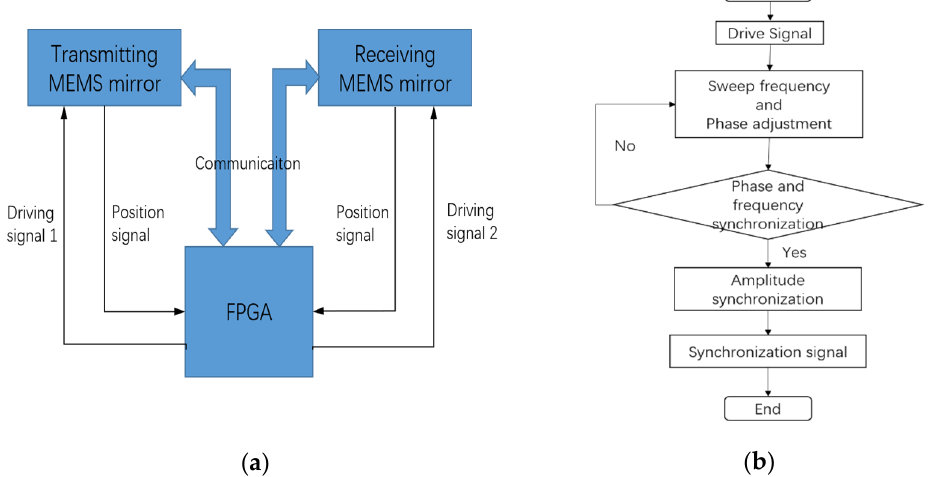
Figure 4. ( a ) Diagram of the MEMS mirror synchronization; ( b ) procedure of the MEMS mirror synchronization.